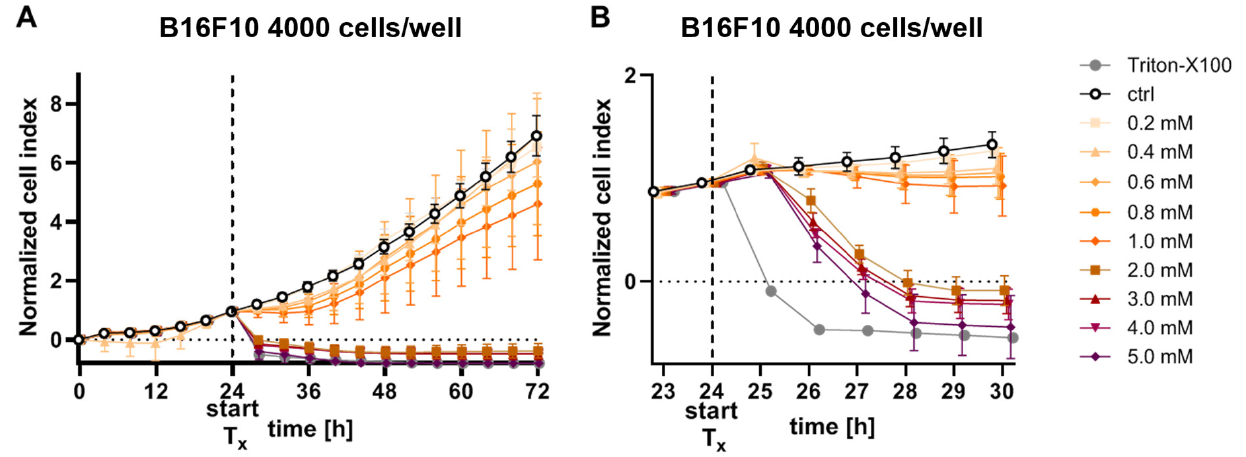
Figure 2. Real-time antiproliferative activity of ascorbate on B16F10 cells. B16F10 mouse melanoma cells were treated with varying amounts of ascorbate (0–5 mM). Cellular viability of treated wells was monitored by impedance measurement at 30 min intervals and compared to the medium-treated control. ( A ) The viability is shown in 4 h intervals over the complete period of 72 h. ( B ) The viability is shown in 1 h intervals in the first 6 h after treatment start. Depicted are the mean values ± SD of three stand-alone experiments, measured in quadruplicate, respectively ( n = 11 for controls, n = 12 for treated cells). SD, standard